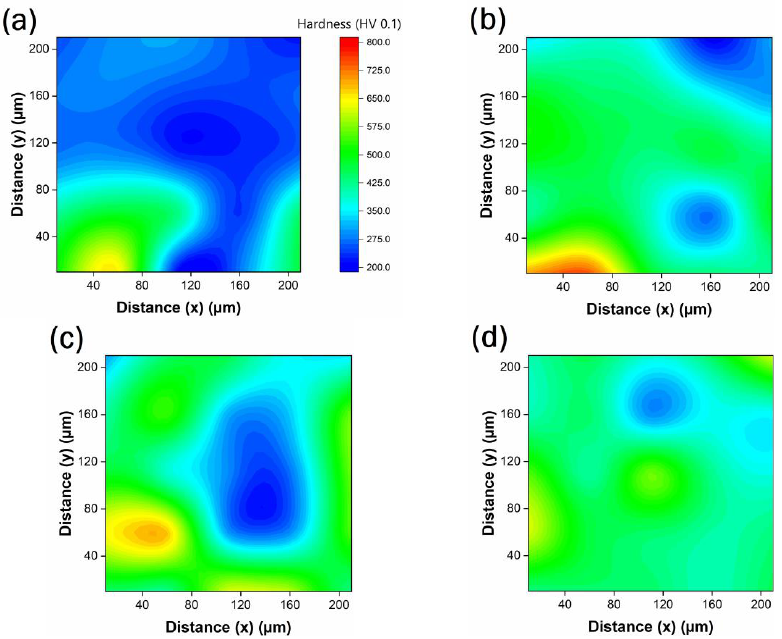
Figure 8. Microhardness maps of ( a ) as-built, ( b ) HIPed samples, and the samples solution annealed at ( c ) 1320 and ( d ) 1360 °C. at ( c ) 1320 and ( d ) 1360 ◦